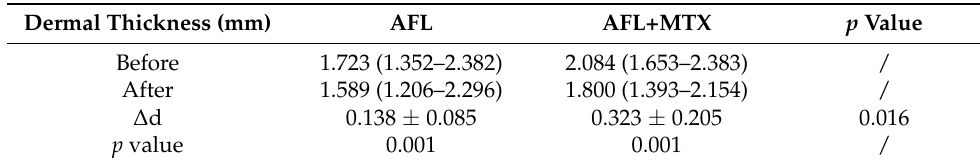
Table 3. The dermal thickness four weeks before and after treatment. Data are expressed as median and inter-quartile range. ∆ d is the difference value of the dermal thickness four weeks before and after treatment. Data are expressed as mean ± standard deviation. AFL group was treated by ablative fractional laser and AFL+MTX group was treated by ablative fractional laser-assisted delivery of methotrexate.